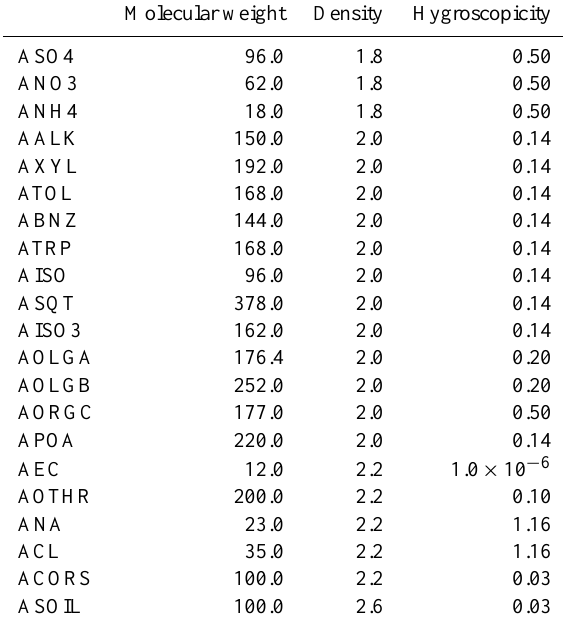
Table 3. Molecular weight (gmol − 1 ), density (gcm − 3 ) and hygroscopicity of each aerosol species used in this study (see the explanations in the text).